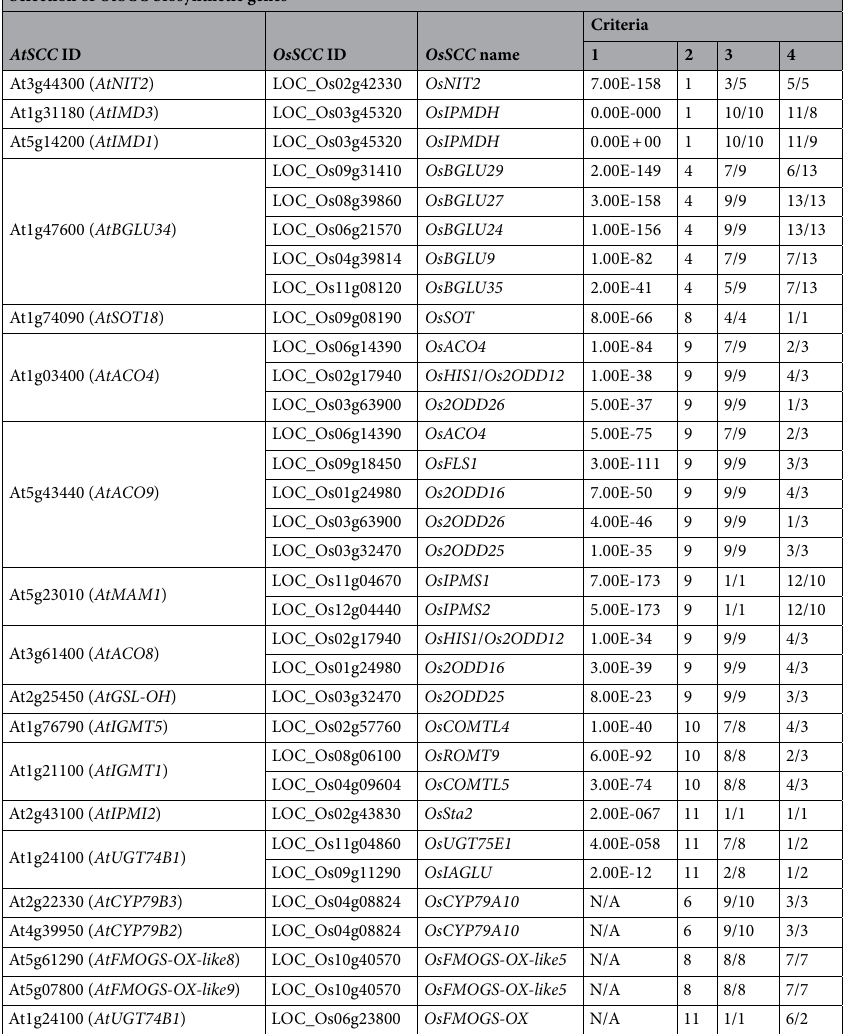
Table 1. Mining for Oryza sativa sulfur-encoding biosynthetic genes ( OsSCC) with Arabidopsis sulfur- encoding biosynthetic gene ( AtSCC) input data. Selection criteria are described as following: (1) synteny events; (2) phylogenetic clade; (3) motif composition (Os/At); and (4) number of exon (EN) with AtSCC biosynthetic genes